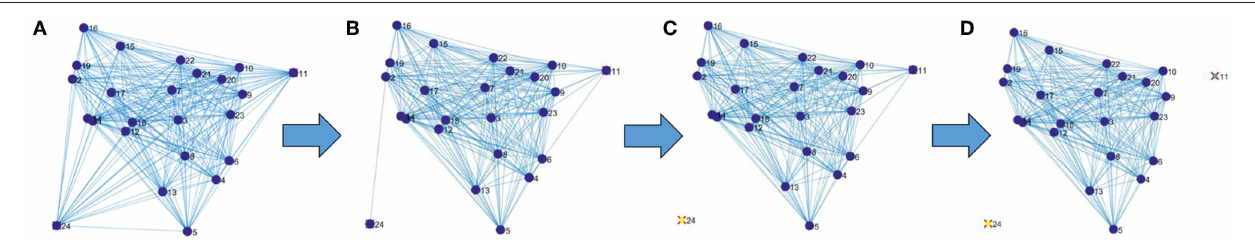
FIGURE 1 | Example of application of the percolation method. Starting with a fully connected graph (A) links are removed according to their distances (longer distances are removed first). In (B) some of the longest connections have been eliminated, but the graph remains fully connected, in (C) the first outlier is identified as the first element that becomes disconnected from the giant connected component, and in (D) two elements are disconnected. A video illustrating the procedure is presented in the Supplementary Information .